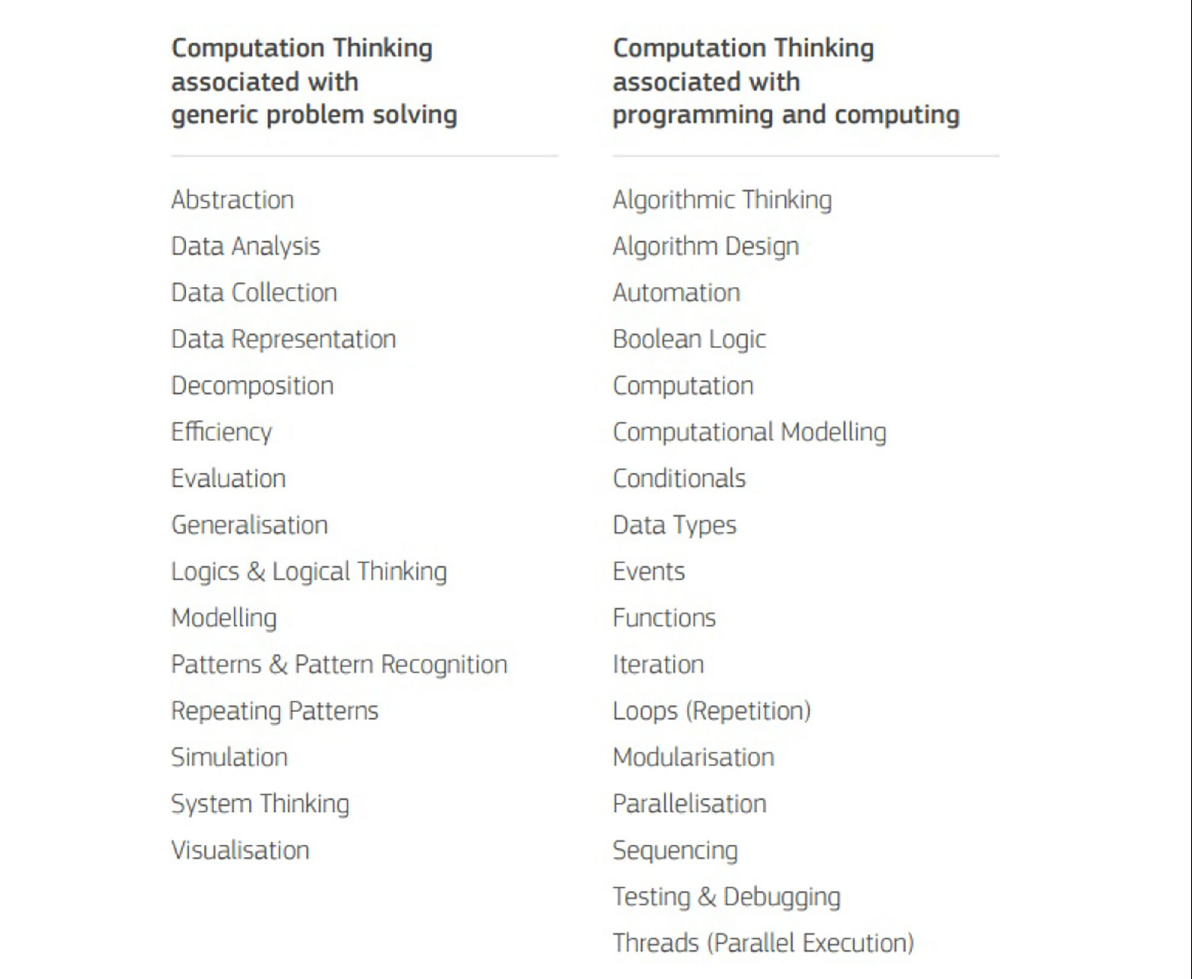
FIGURE1 Concepts concerning computational thinking (CT) skills development, adapted from Bocconi et al.